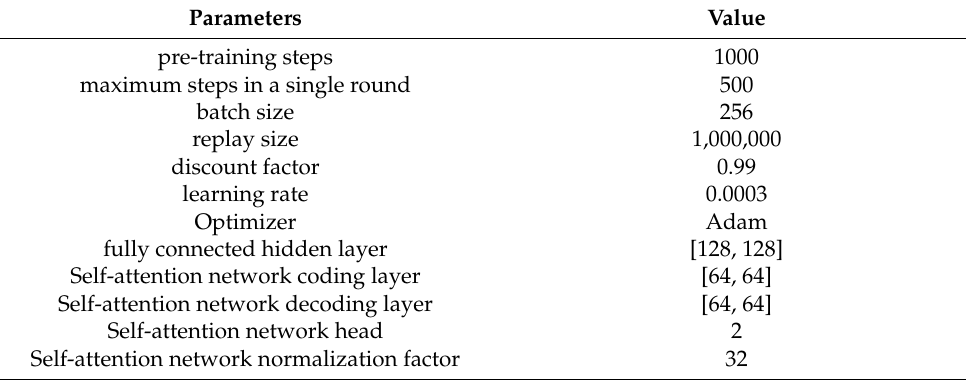
Table 3. Training hyperparameters and neural network structure. Parameters Value pre-training steps 1000 maximum steps in a single round